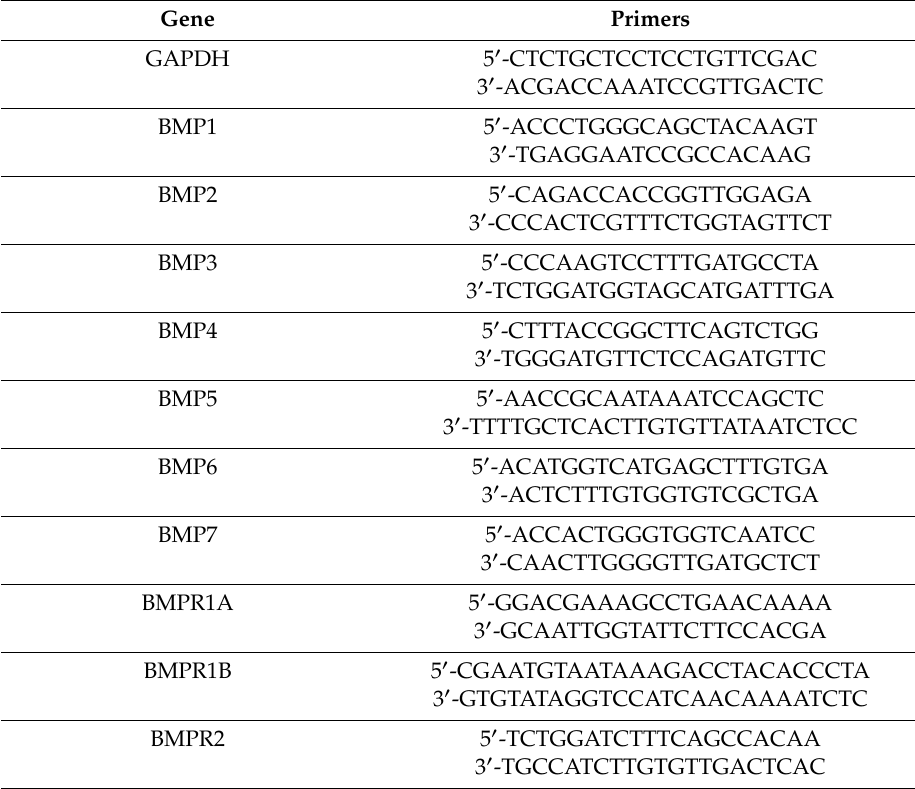
Table 1. Primers for qPCR